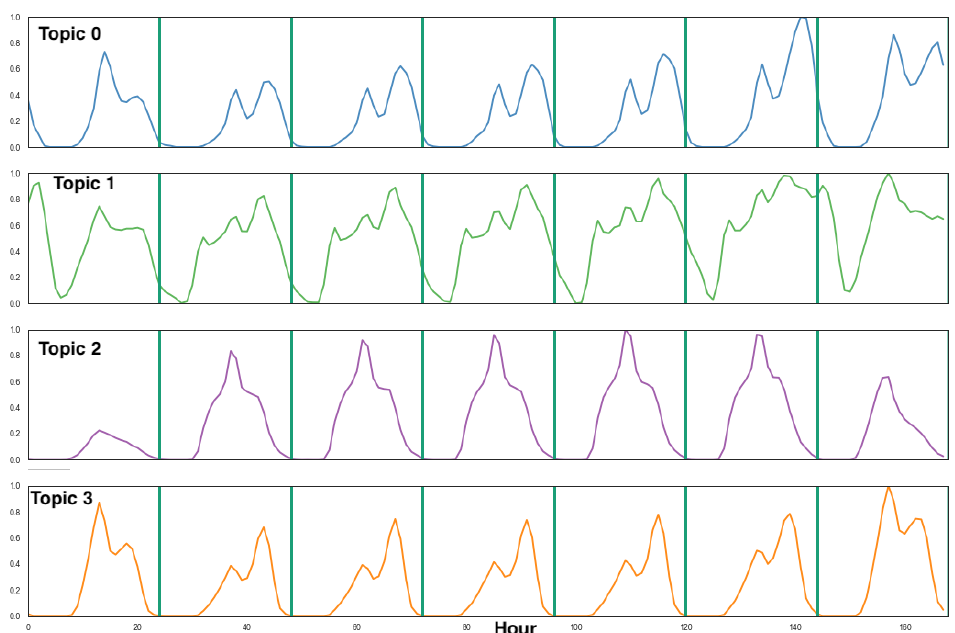
Figure 6. LDA detected topics in Santiago City, K = 4. The vertical partitions correspond to days of the week starting from Sunday. The x -axis is the time measured in hours. The y -axis is the normalized values of the activity pattern.